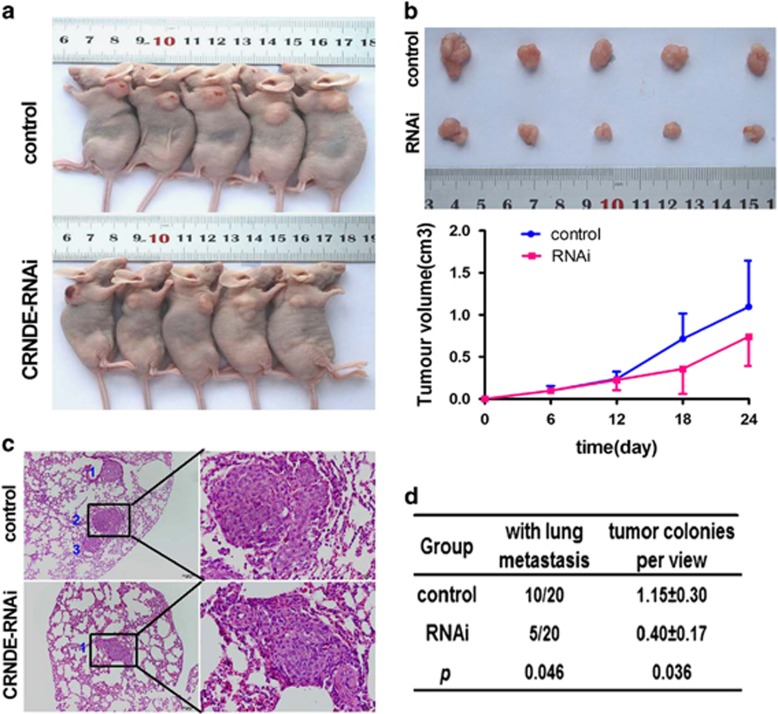
The CRNDE depletion inhibits the growth and metastasis of human CRC cells in mice in vivo. (a) DLD1 cells with stable CRNDE downregulation and control cells were inoculated into nude mice. These graphs show the tumor xenografts 4 weeks after ectopic-subcutaneous implantation in nude mice. (b) DLD1 cells with downregulated CRNDE expression exhibited attenuated tumor growth in nude mice. The effect of CRNDE on CRC tumor growth was evaluated based on tumor volume in the two groups. (c) Representative pictures of lung metastasis by hematoxylin and eosin (H&E) staining in nude mice 4 weeks after tail vein injection with CRNDE downregulated DLD1 cells or control cells. (d) Statistical comparisons of lung metastasis and pulmonary tumor colonies per view in the two groups of mice after tail vein injection